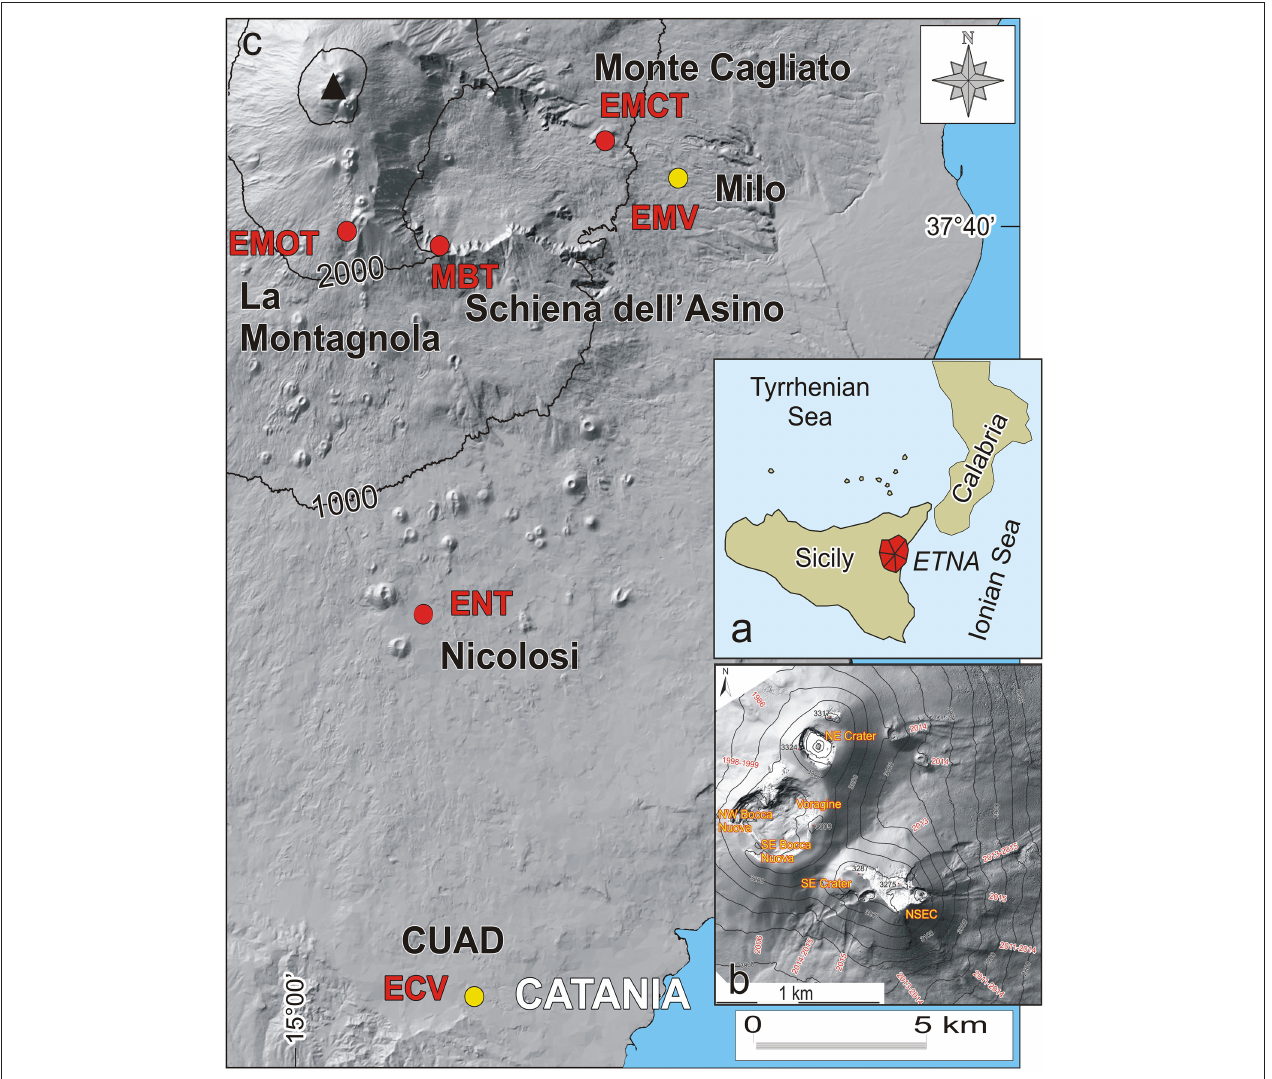
FIGURE 2 | (a) Map of southern Italy, showing the location of Mt. Etna (in red) in the eastern portion of Sicily. (b) Map of Etna’s summit craters (modified after Neri et al., 2017), with the NE Crater, Voragine, the NW and SE pits of Bocca Nuova, the SE Crater, and the New SE Crater (NSEC) built up on its east flank since 2011. (c) Map of the SE flank of Etna volcano, modified after Calvari et al. (2011), showing the location of the thermal (red circles) and visual (yellow circles) monitoring cameras used in this paper. The black triangle shows the position of the summit craters, magnified in (b)